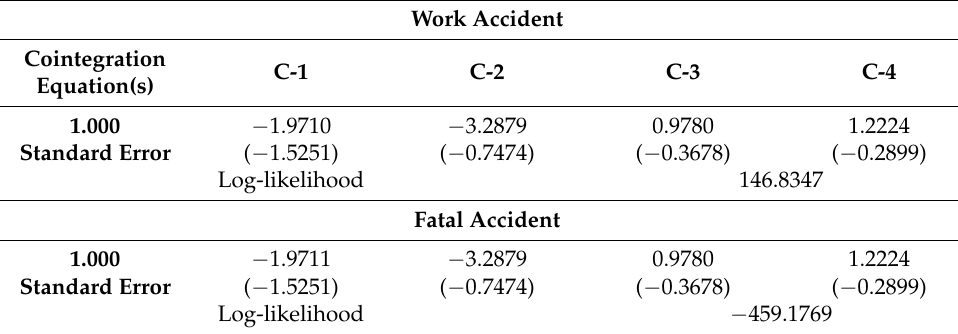
Table 5. Normalized cointegration coefficient.